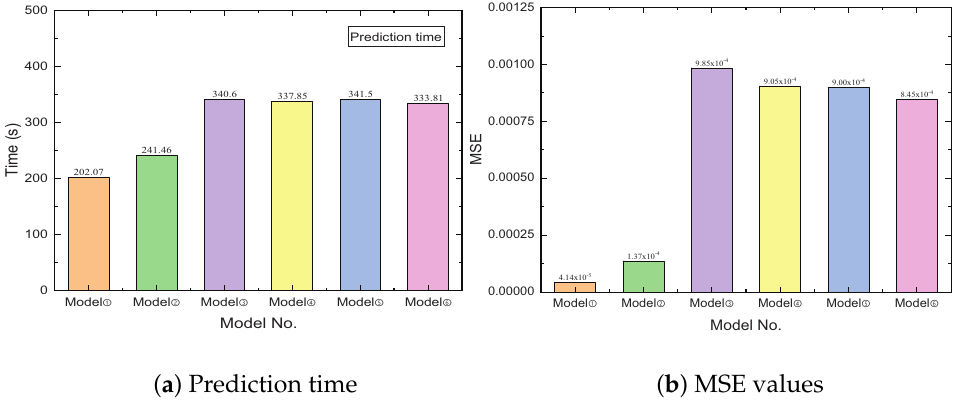
Figure 7. Model energy efficiency